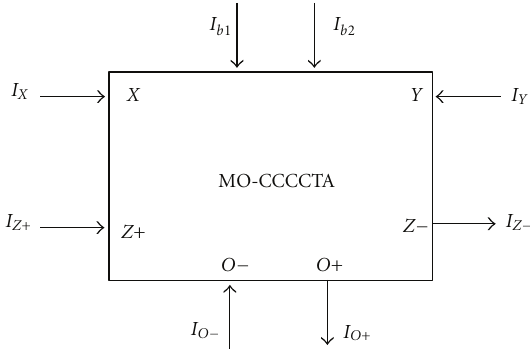
Figure 1: The functional symbol of MO-CCCCTA.